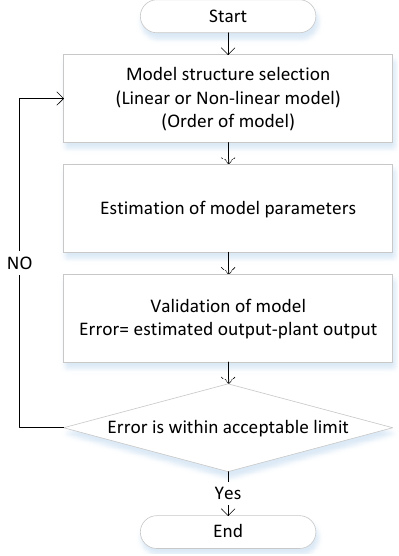
Figure 8. Parametric